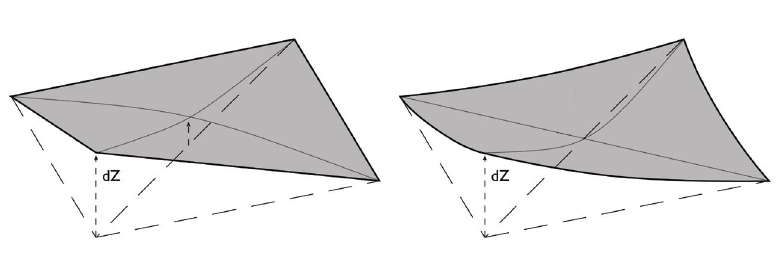
Figure 2 and 3: Schematic representation of the first and second deformation mode